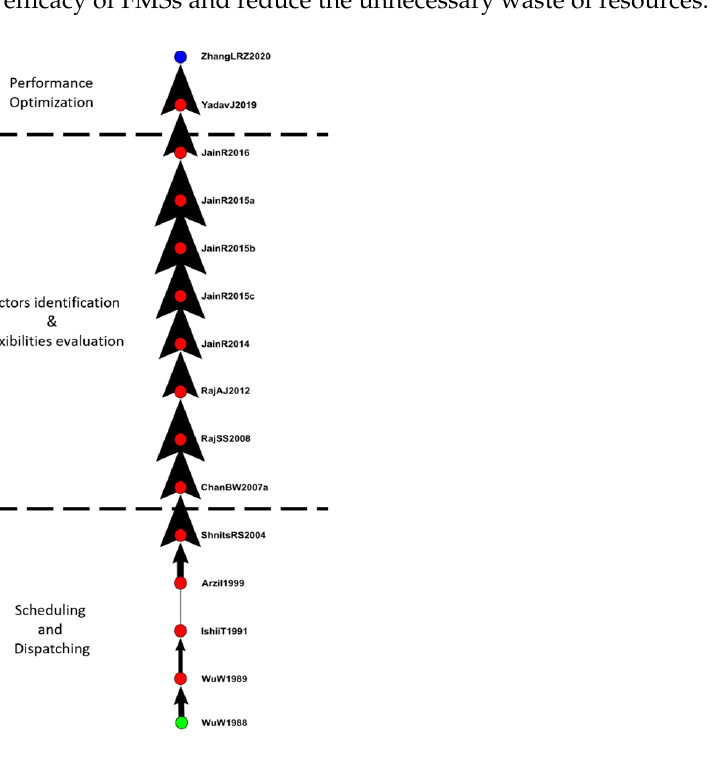
Figure 7. Global main path of FMS deadlock prevention.